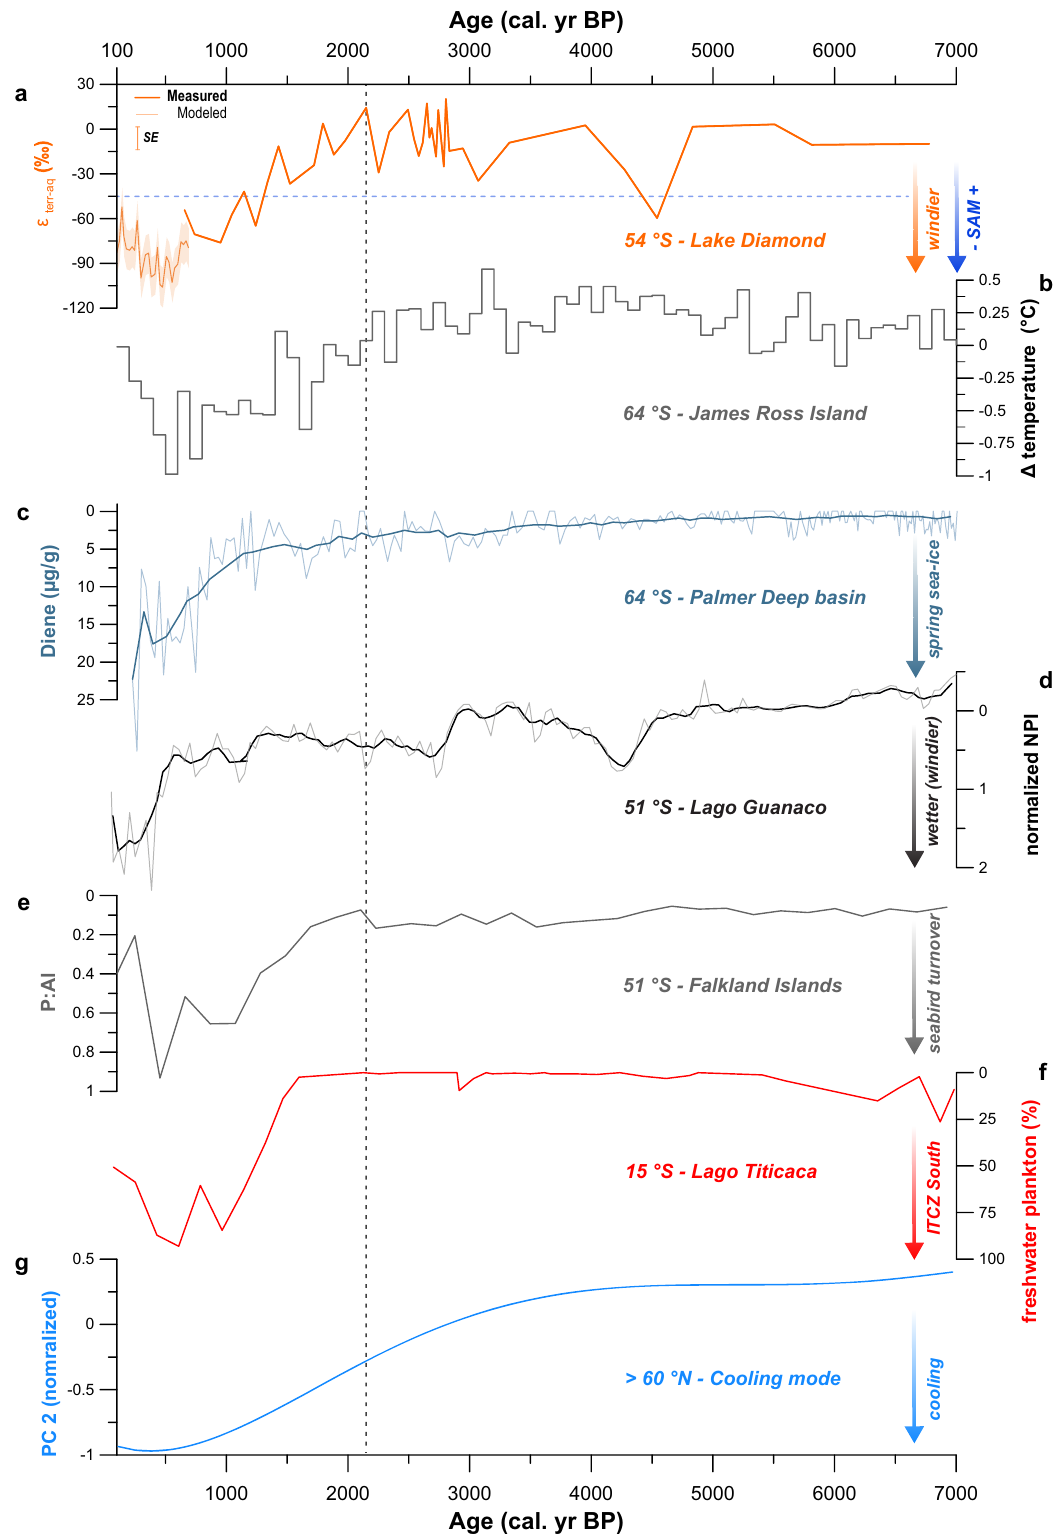
ensuing Tropical Paci fi c cooling leads to low sea-level pressure anomalies in the sub-Antarctic. Recently, it has been shown that these connections also operate on centennial timescales 17 . How- ever, while the reconstructed SAM minimum ~500 cal. yr BP (Fig. 8) coincides with a phase of El Niño-dominated conditions 89 , no consistent link exists between records of SAM-like